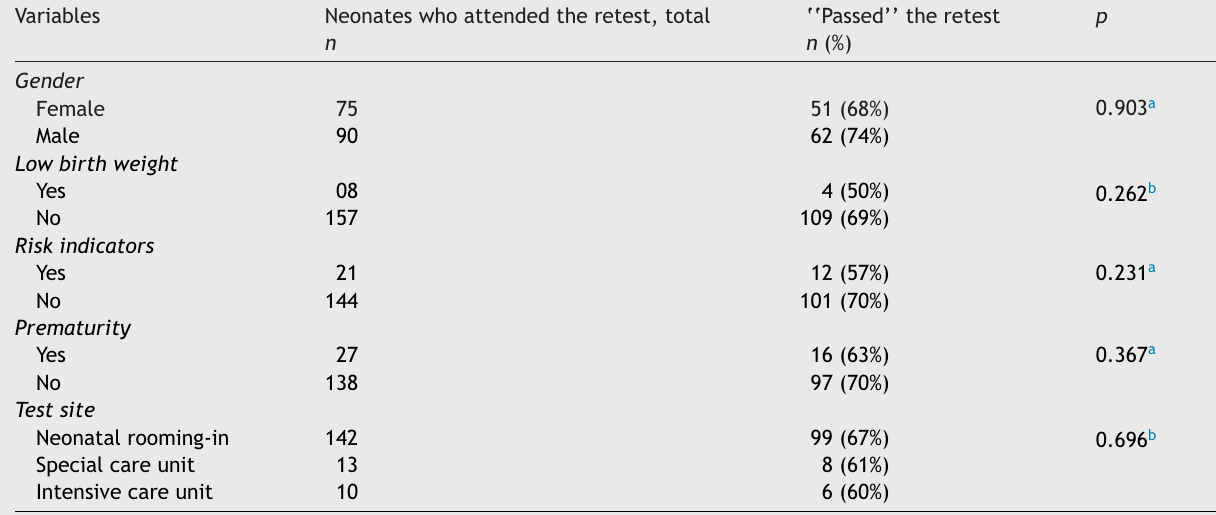
Relationship between ‘‘to pass’’ the retest on the left ear and the following variables: gender, low birth weight, risk factors, prematurity and test site.